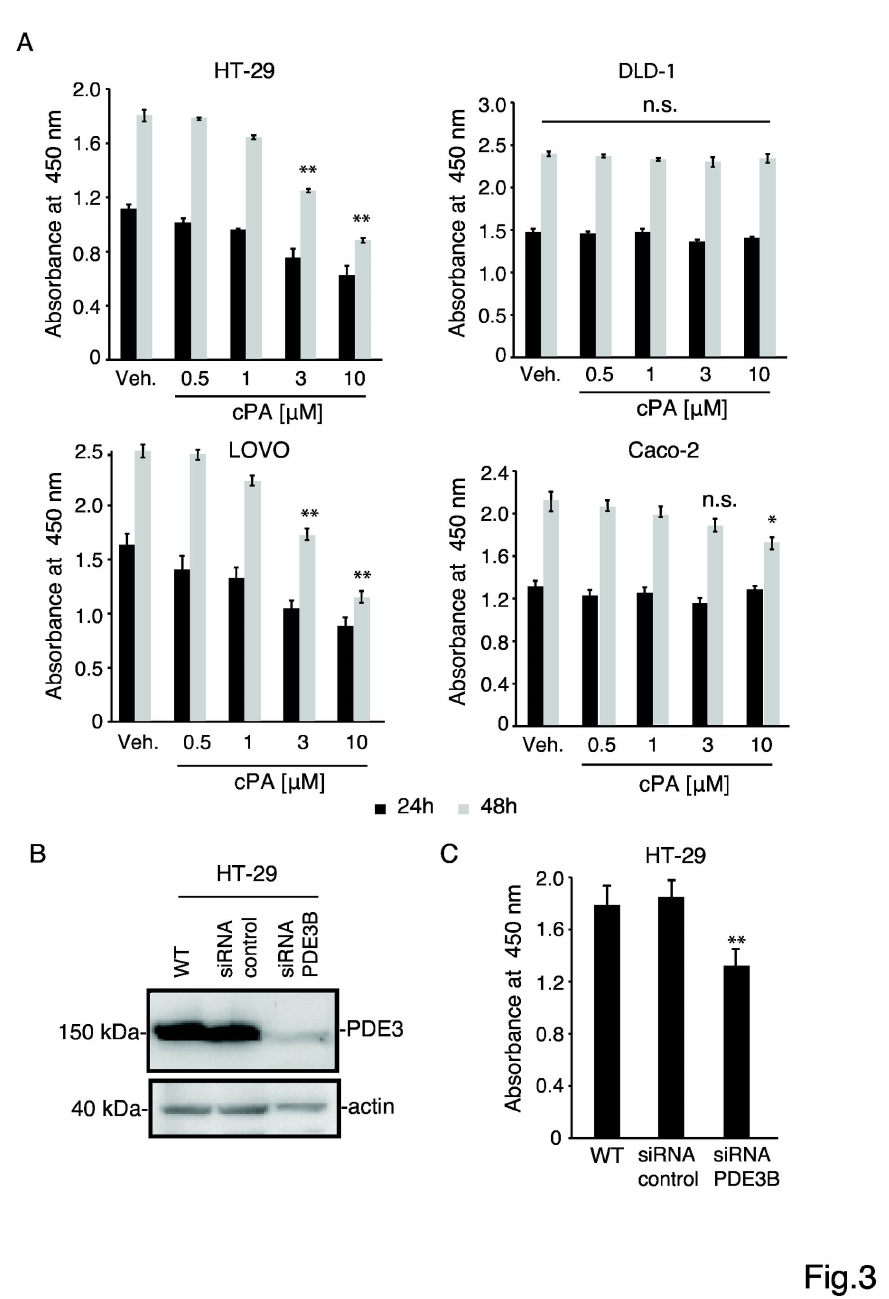
Figure 3. (A) Dose-dependent inhibition of cell growth by cPA was evaluated using the Cell Counting Kit-8. Cells (1 × 10 5 cells/well) were seeded in 6-well plates and incubated for 24 h or 48 h at 37°C with 5% CO Kit-8 solution was added to the medium. After incubating for 2 h more, the amount of orange formazan dye generated was determined by measuring the absorbance at 450 nm using a microplate reader. Data are expressed as means ± SEM (n = 4), **p < 0.01. (B) Knocking down PDE3B expression in HT-29 cells. Total protein was extracted from untransfected cells and from cells transfected with control siRNA or PDE3B-specific siRNA and analyzed by western blotting with an anti-PDE3B antibody; β-actin was stained as a protein-loading control. (C) Inhibition of cell growth following PDE3B knockdown was measured using the Cell Counting Kit-8. Cells (1 × 10 5 cells/well) were seeded in 6-well plates and incubated for 24 h at 37°C with 5% CO Cell Counting Kit-8 solution was added to the medium. After incubating for 2 h more, the amount of orange formazan dye generated was determined by obtaining the absorbance at 450 nm using a microplate reader. Data are expressed as means ± SEM (n = 4), **p < 0.01.